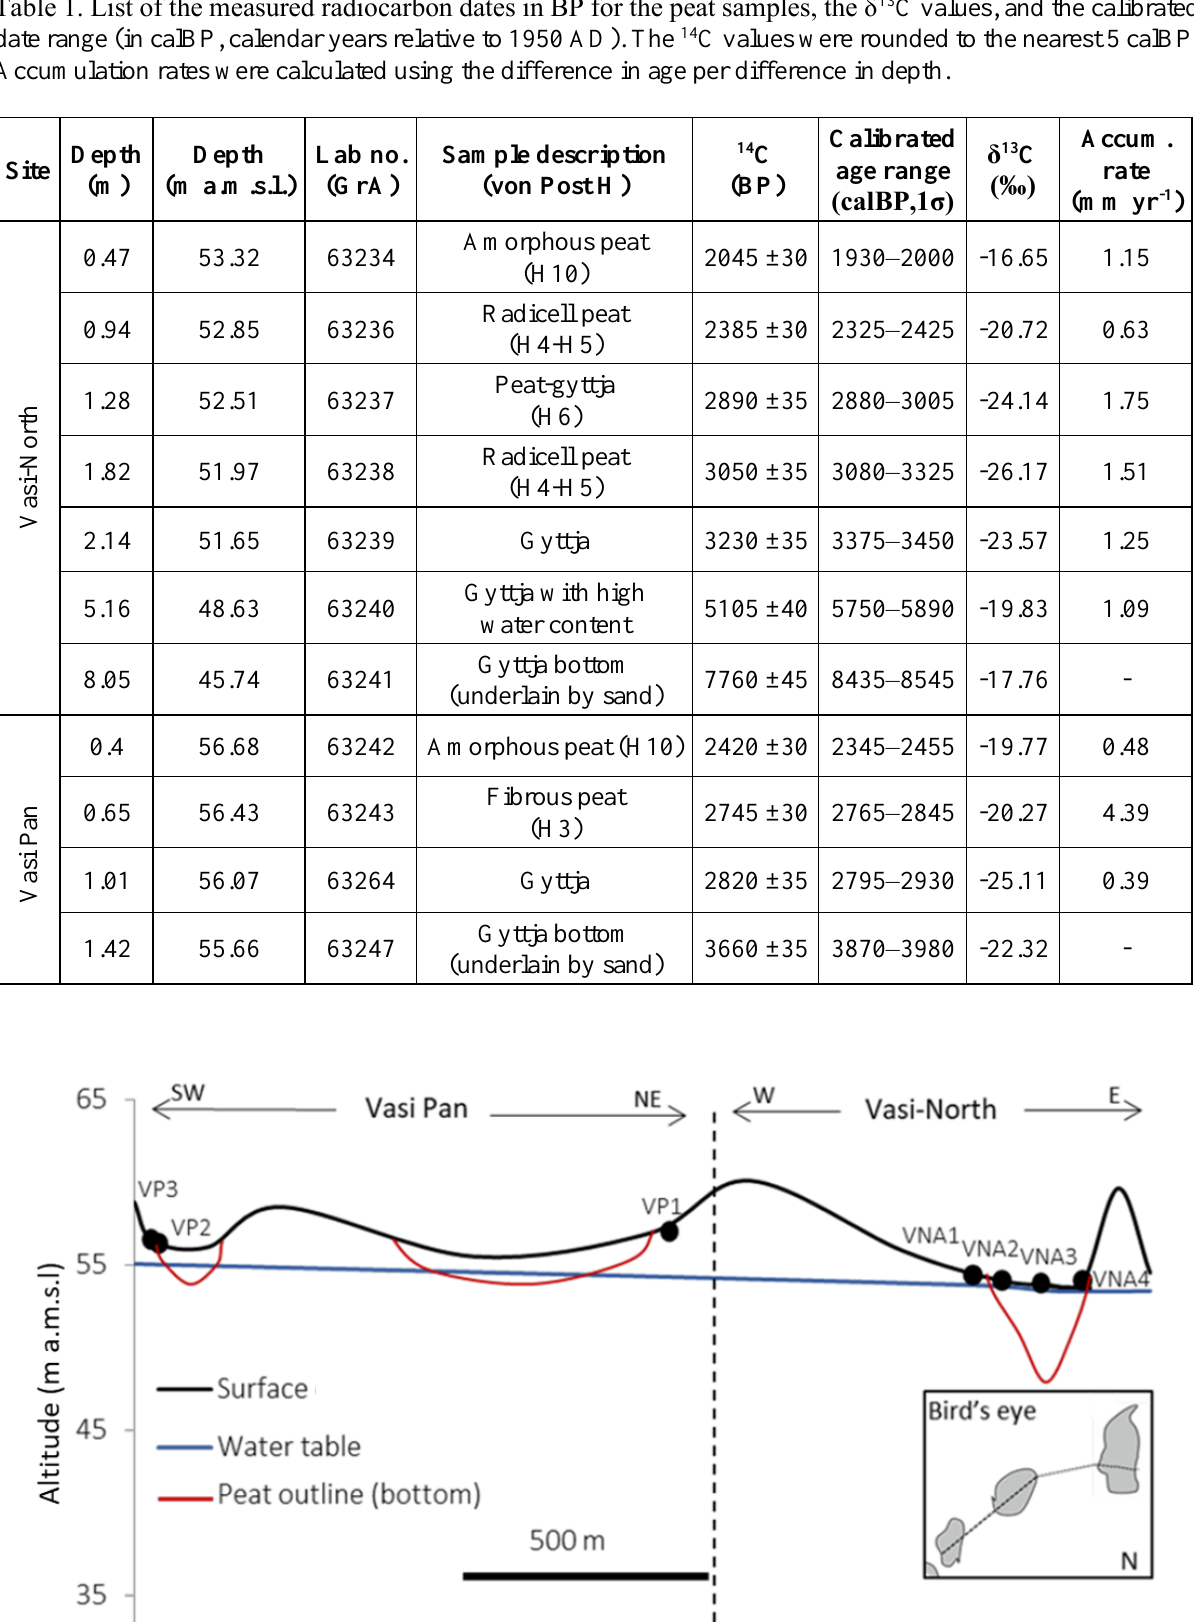
Figure 4. Topographic relief (black line) and water table depth (blue line) along a transect (main transect) extending through Vasi Pan (0–1200 m, SW to NE direction) and Vasi-North (1200–2000 m, W to E direction); water table depth was measured on 24 March